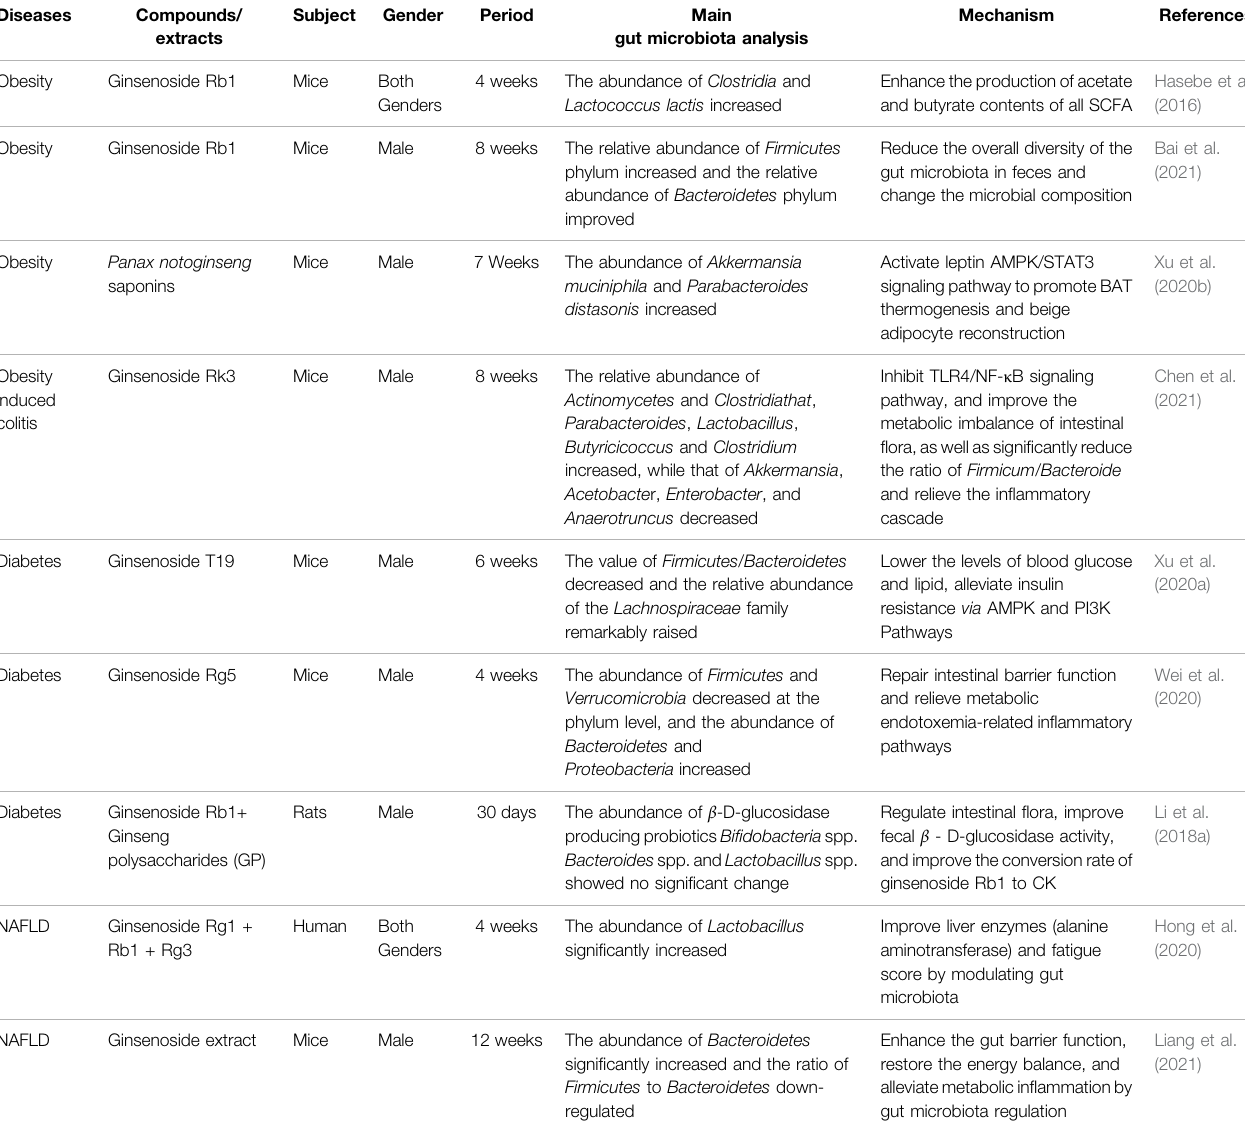
TABLE 1 | Ginsenosides signi fi cantly improve obesity and its complications by regulating gut microbiota. Diseases Compounds/